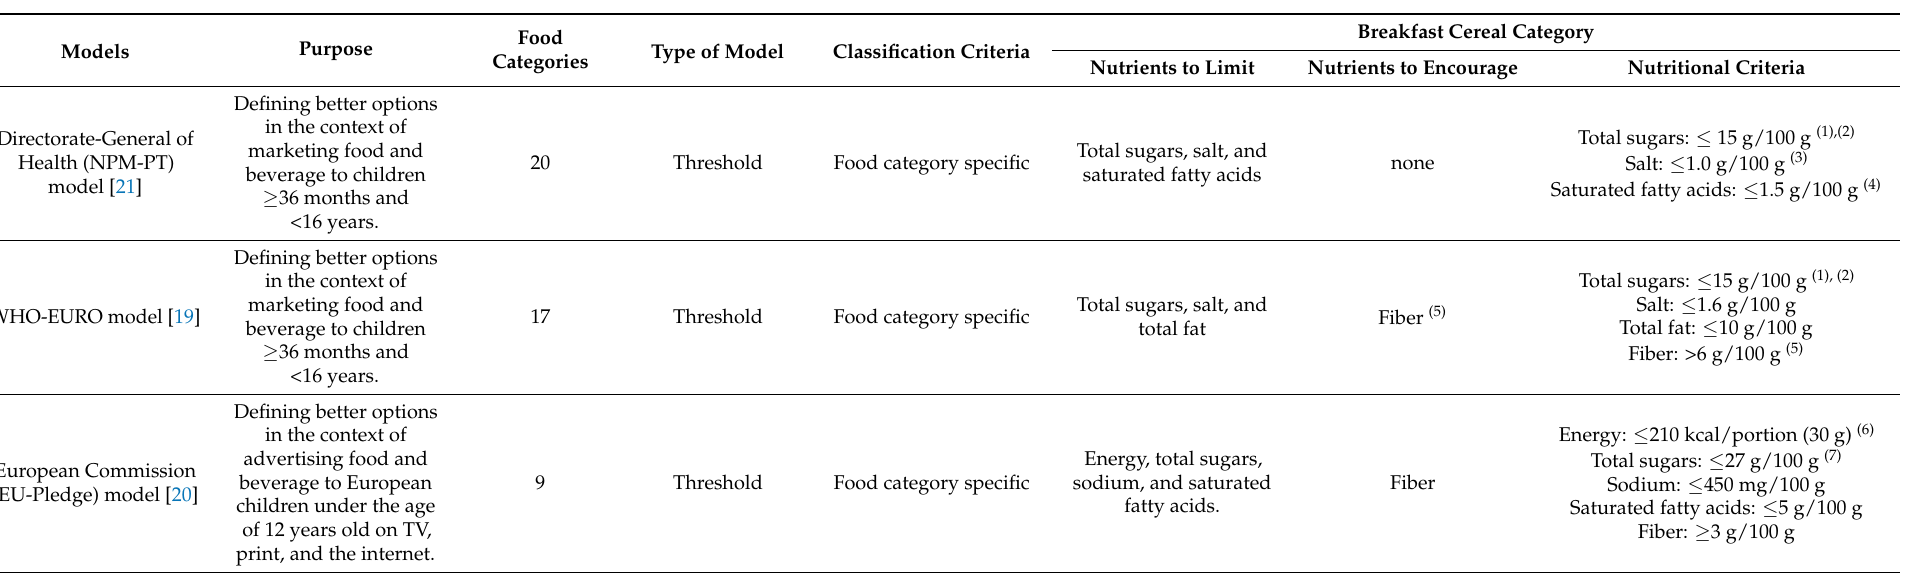
Table A1. Characteristics of the three nutrient profile models considered in this